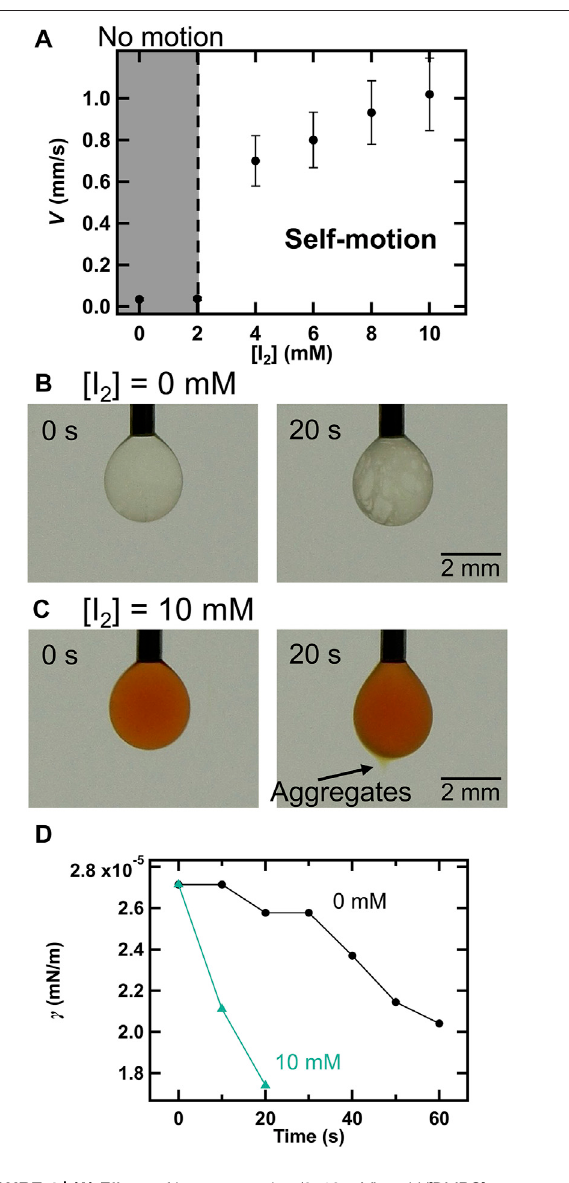
FIGURE 4 | (A) Effects of I 2 concentration (0 – 10 mM) on V ([DMPC] = 1.0 mg/ml and [TSAC] = 1.0 mM). Snapshots of the droplet when (B) [I 2 ] = 0 mM and (C) [I 2 ] = 10 mM. (D) Changes in γ with time at different I 2 concentrations (the concentrations of DMPC and I 2 were the same as those in the cases of (B) and (C)